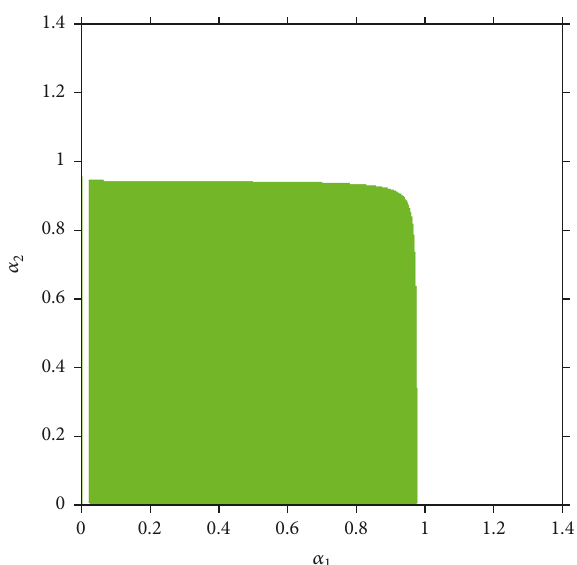
Figure 1: Stable region of system (9) with (𝛼 1 ,𝛼 2 ).